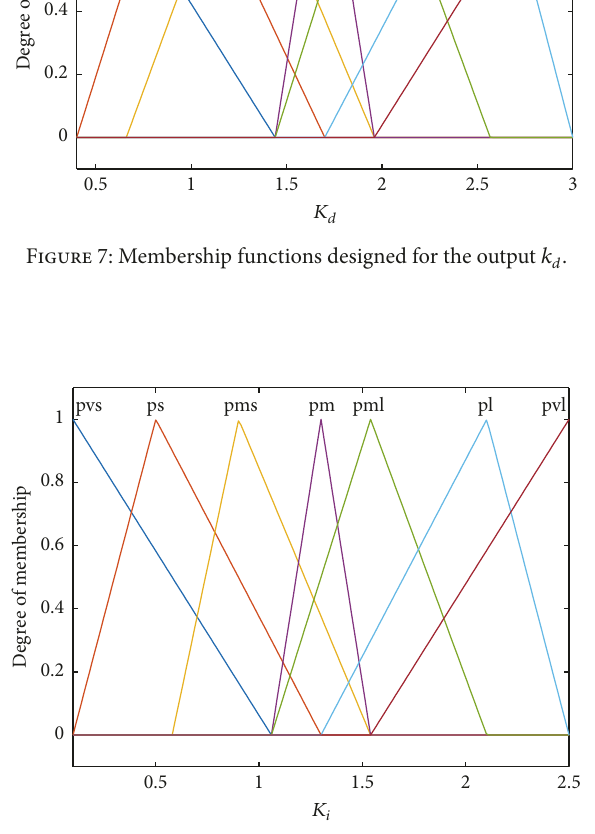
Figure 8: Membership functions designed for the output 𝑘 𝑖 .